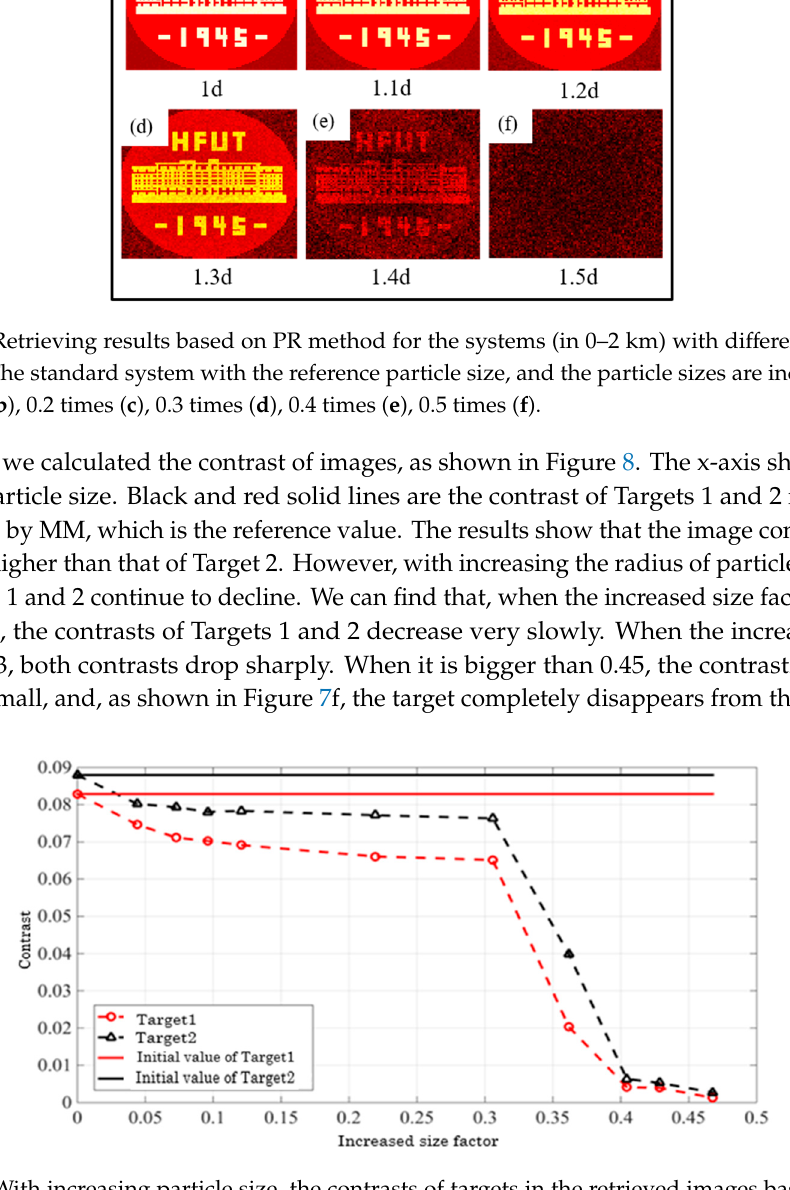
Figure 8. With increasing particle size, the contrasts of targets in the retrieved images based on the initial MM.